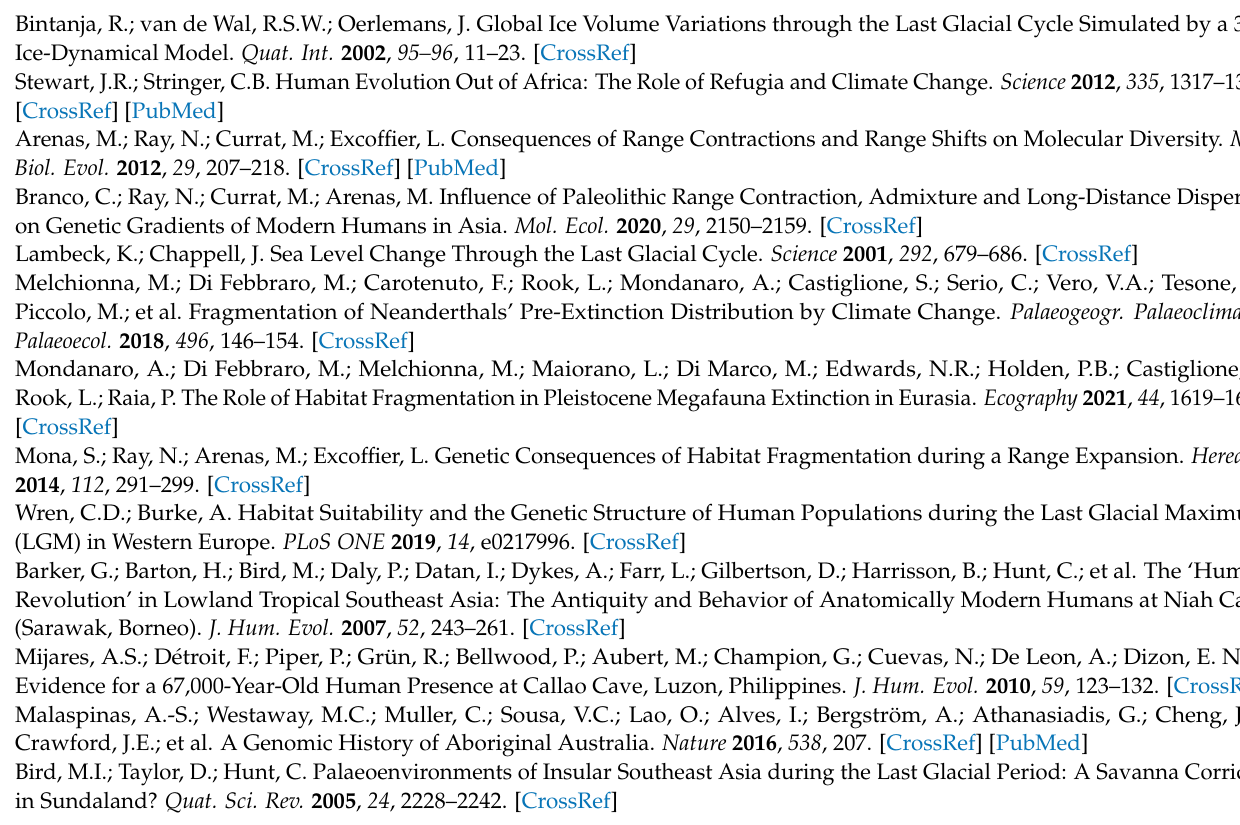
scenarios; Figure S5: Boxplots displaying the distribution of the selected summary statistics computed from the data simulated under each evolutionary scenario; Figure S6: Goodness-of-fit of the data simulated under every evolutionary scenario; Figure S7: Power of the ABC multinomial logistic regression and neural networks based methods for selecting an evolutionary scenario among the stud- ied evolutionary scenarios; Figure S8: Prior and posterior distributions of the parameters estimated under the best-fitting evolutionary scenario (LGP&LDD)